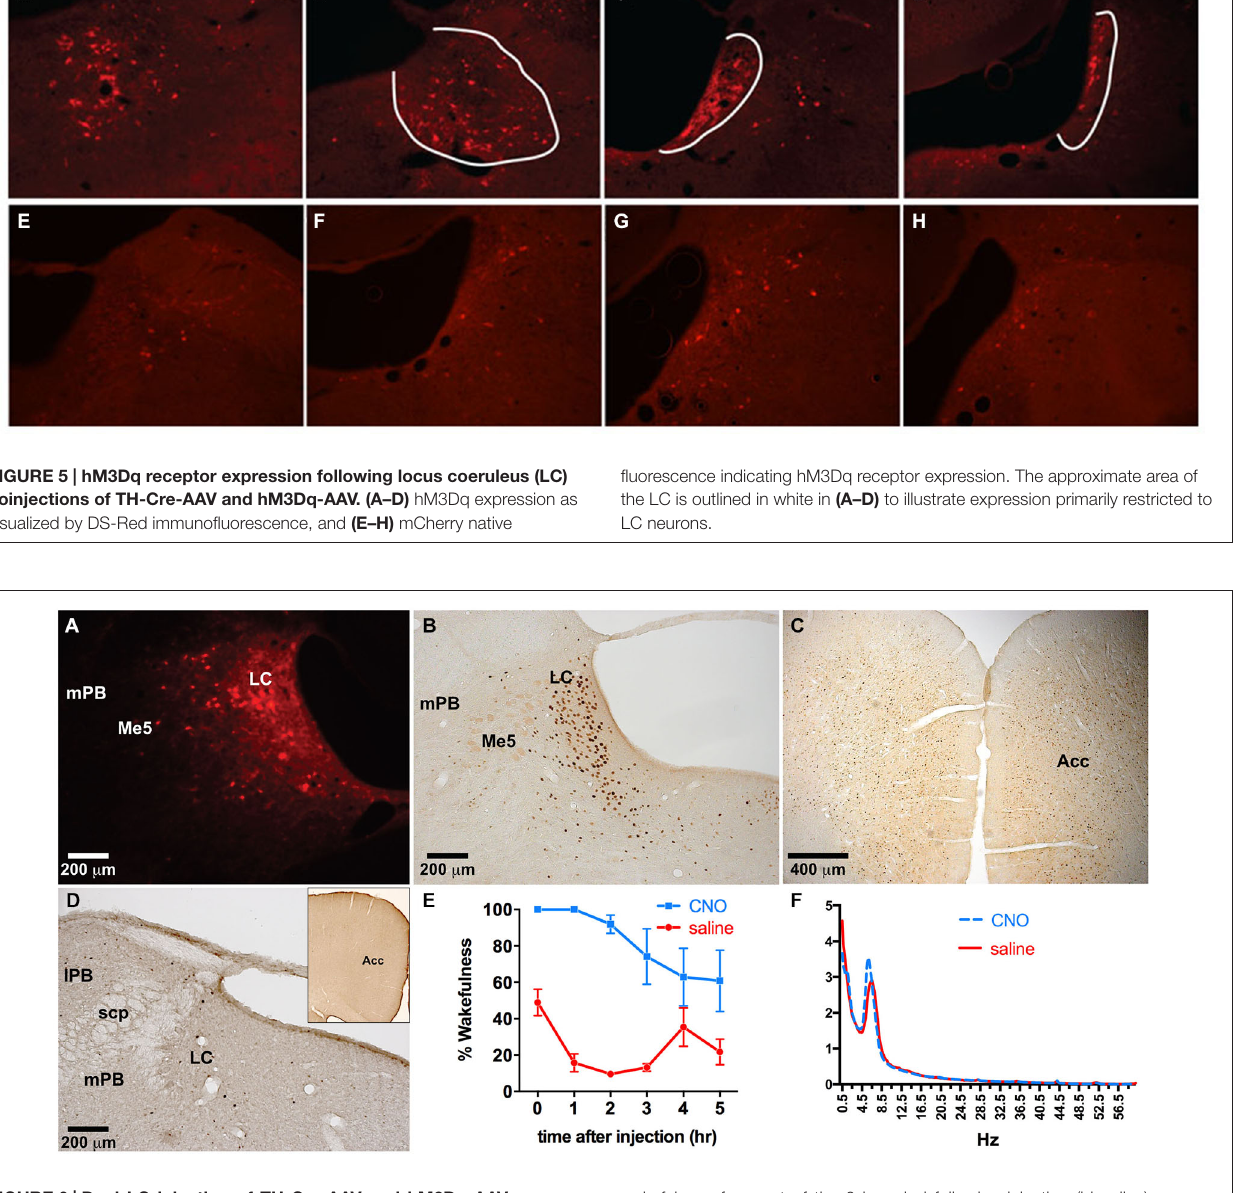
FIGURE 6 | Dual LC injection of TH-Cre-AAV and hM3Dq-AAV. (A) hM3Dq expression is limited to LC neurons. (B–D) Following CNO injections, c-Fos expression markedly increased in the LC (B) as well as the entire neocortex, including the ACC (C) , which was not evident in LC or cortex of animals lacking hM3Dq receptors (D) . (E) CNO induced